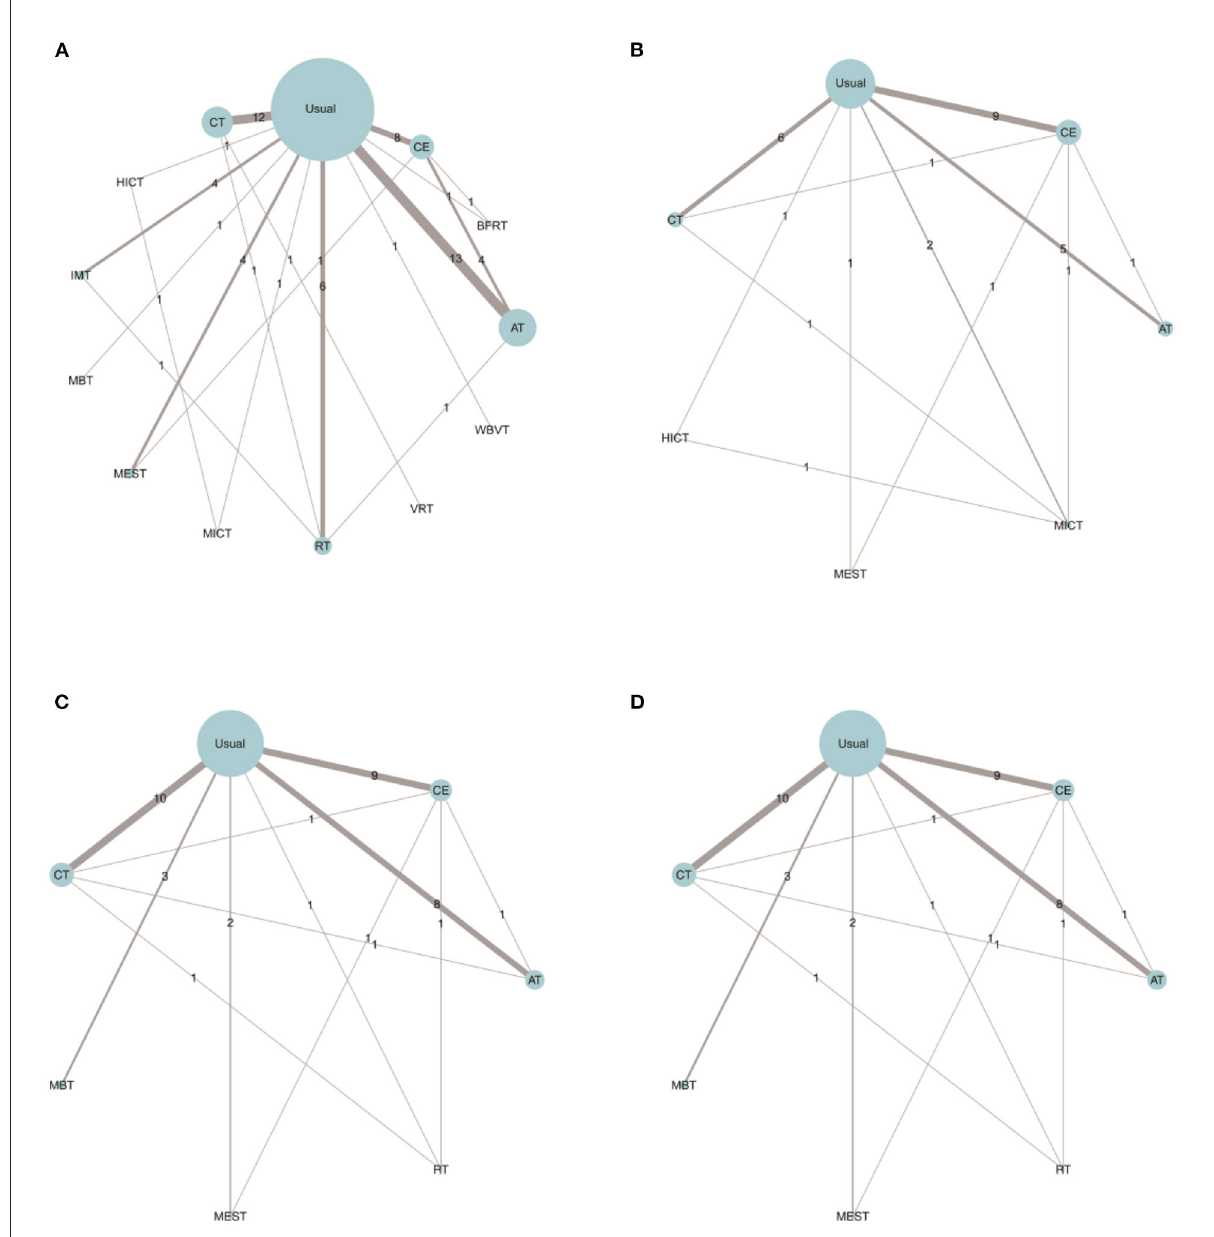
FIGURE2 Comparing the effects of different exercise modalities 6WMT (A) , VO 2 Peak (B) , SBP (C) , and DBP (D) in hemodialysis patients. AT, aerobic training; Usual, usual care; CT, combined training; RT, resistance training; CE, cycle dynamometers; MEST, electrical muscle stimulation;